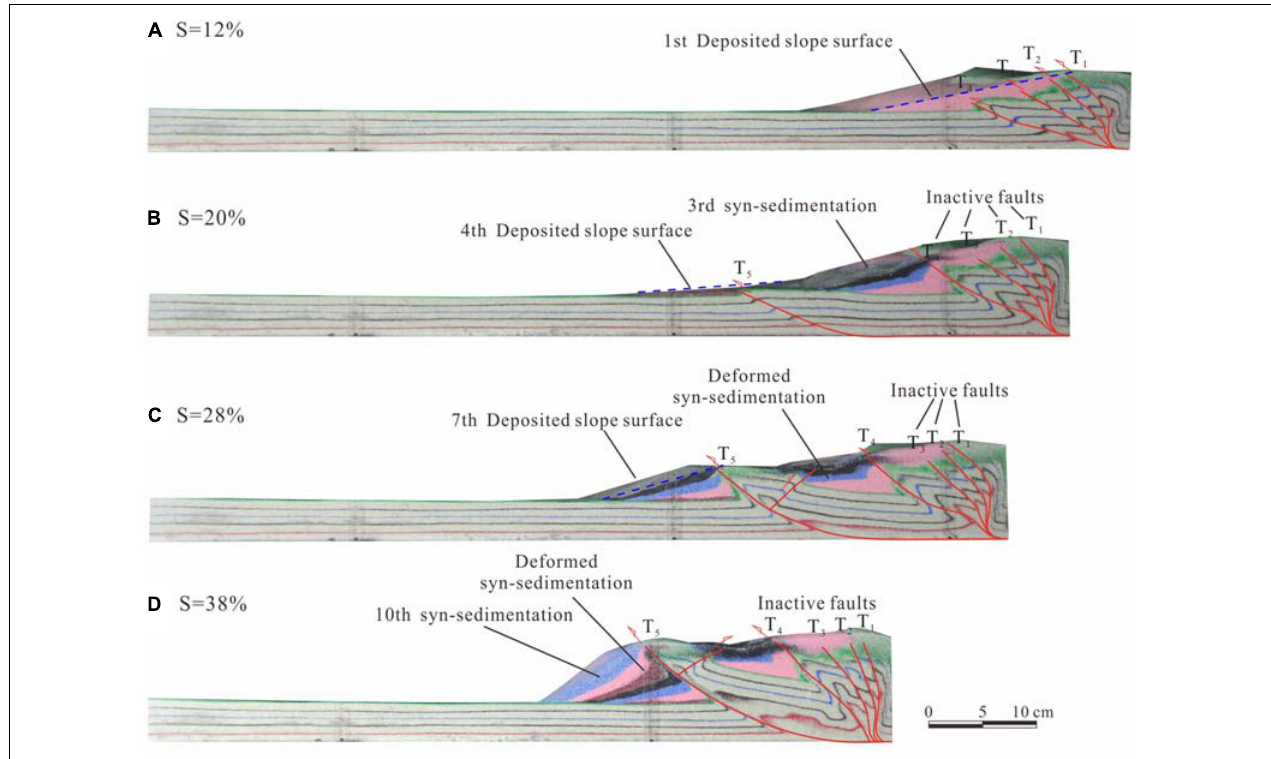
FIGURE 8 | Experiment results of Staved (low-rate) sedimentation model (S1). (A–D) Sequential photographs showing the structural evolution of wedge.